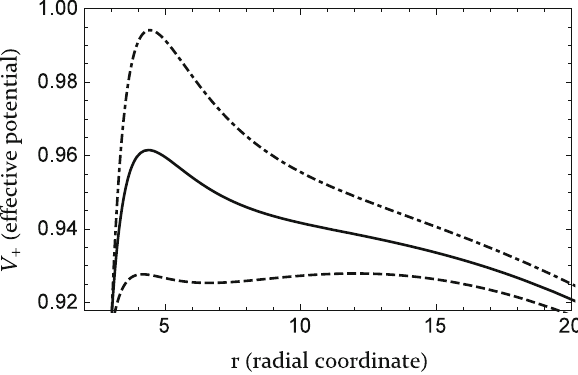
Fig. 1 Qualitative picture of the radial profile of the effective poten- tial for spinning particles with fixed angular momentum in the Schwarzschild–deSitterspacetimeforagivenvalueofthecosmological parameter.Dot-dashed,solid,anddashedcurvescorrespondtospinning particles with positive ( s > 0), zero ( s = 0), and negative ( s < 0) spin,